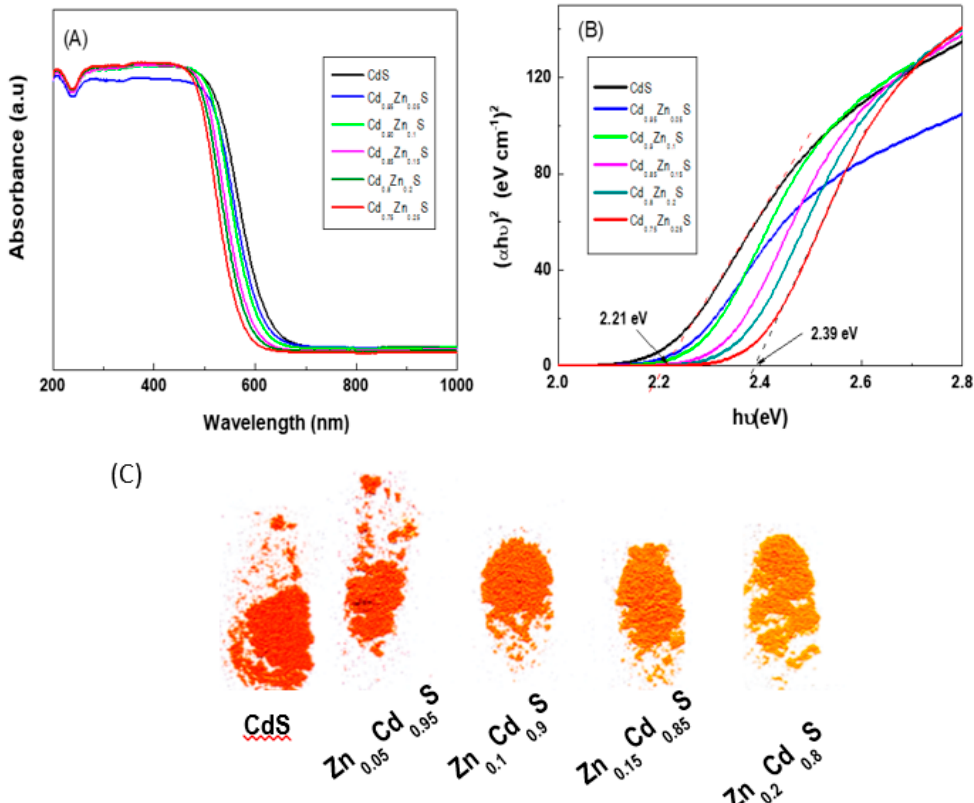
Figure 10. Diffuse Reflectance (DR) UV–Vis spectra of pure CdS and Zn x Cd 1 − x S solid solutions ( A ), Tauc’s plots ( B ) and sample colorings ( C ).